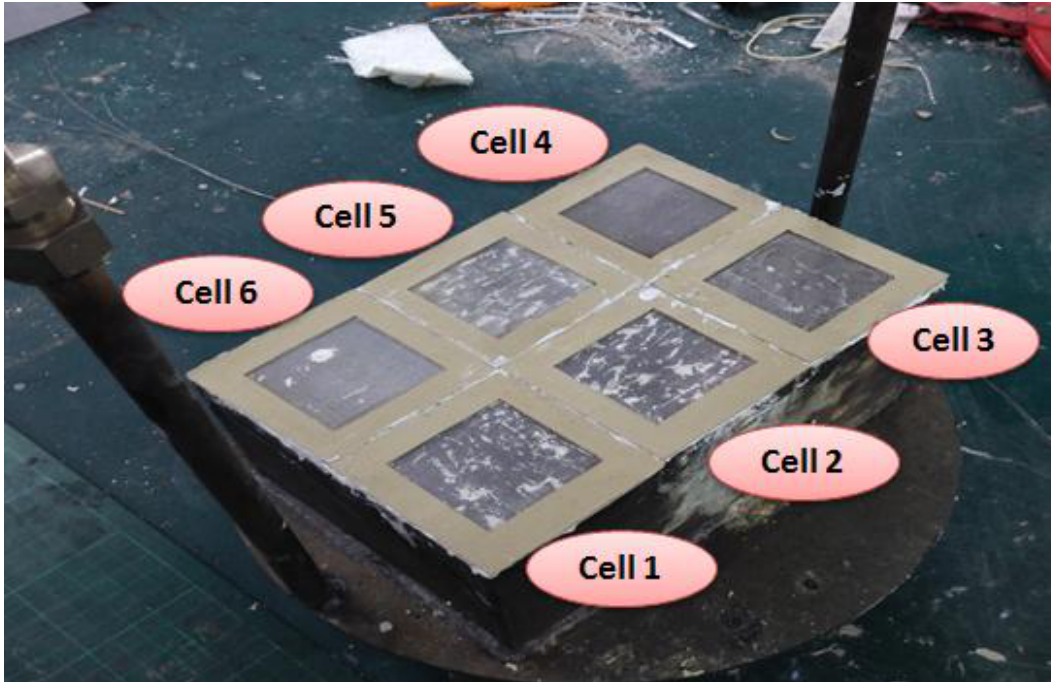
Figure 5. Photograph of the test on the six-cell 2D configuration SOFC stack.